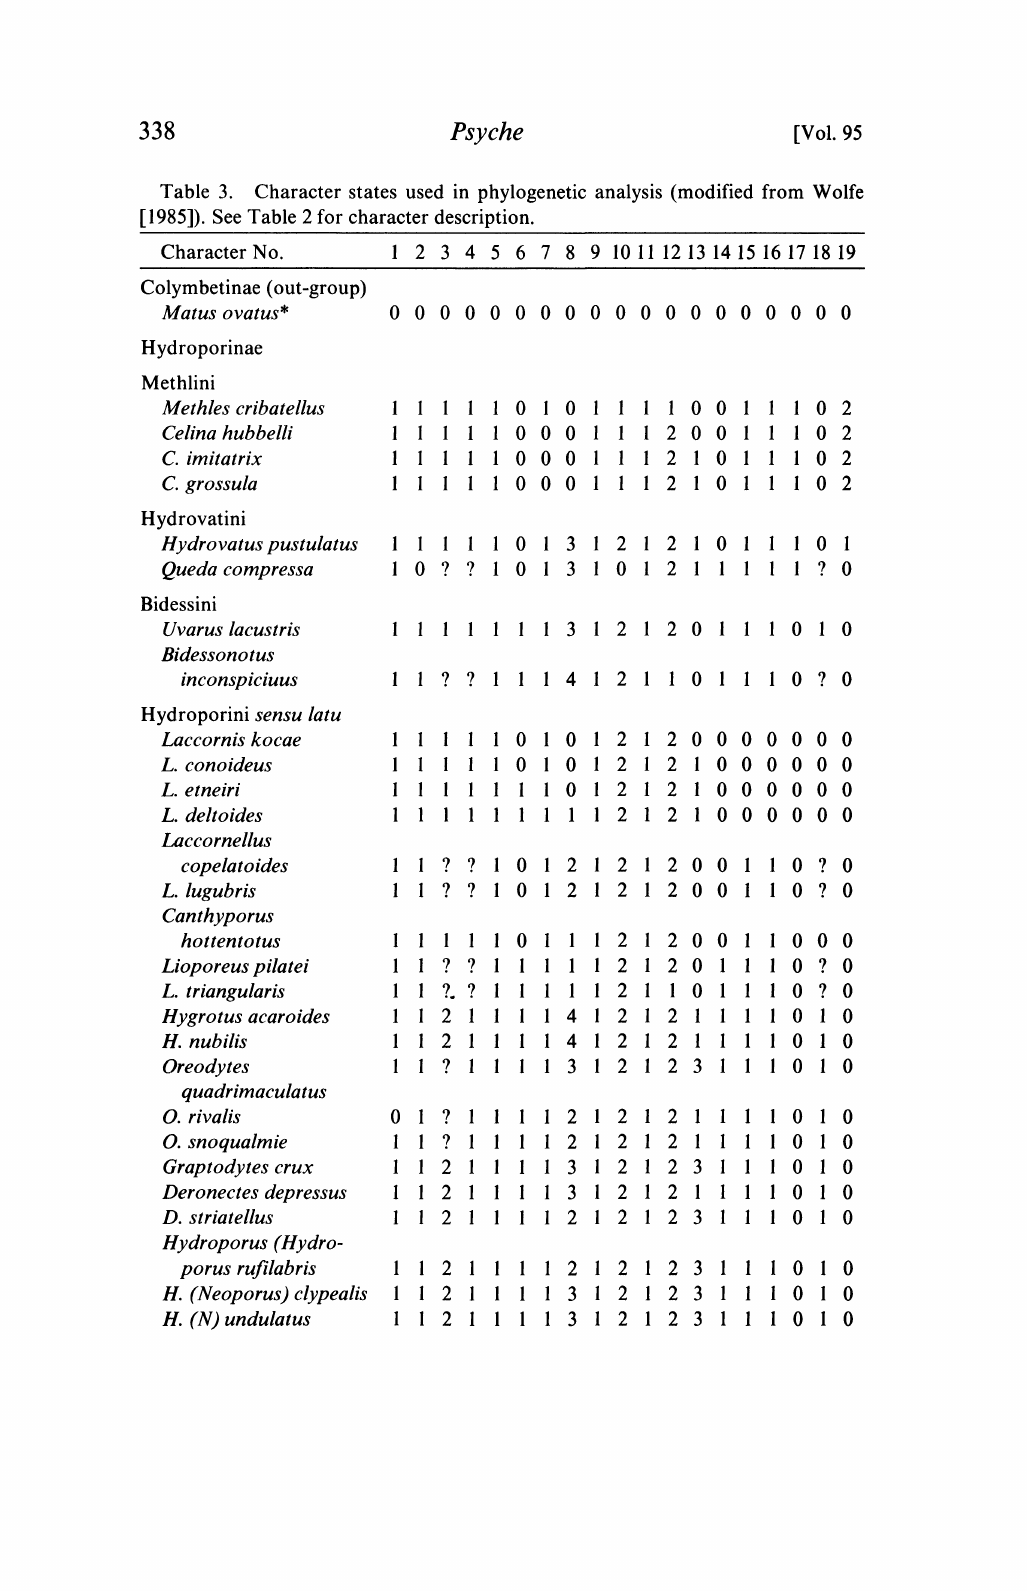
Table 3. Character states used in phylogenetic analysis (modified from Wolfe [1985]). See Table 2 for character description. Character